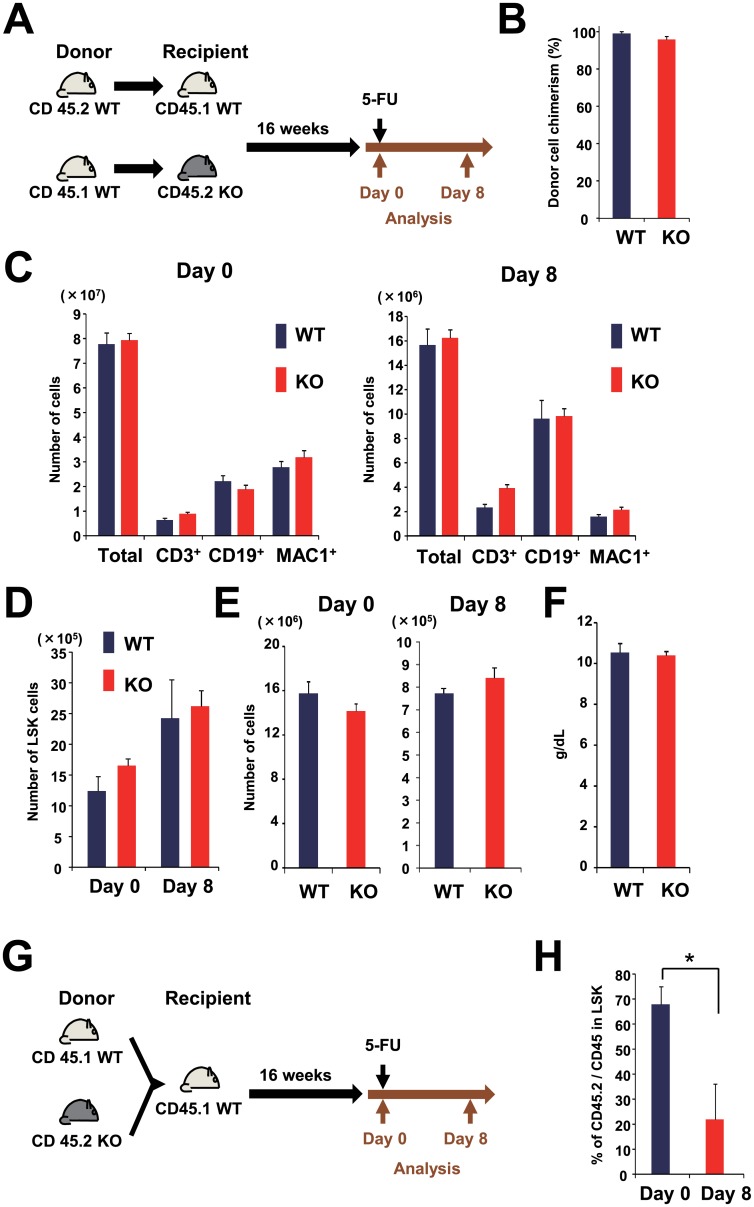
ESAM expression in hematopoietic cells is required for hematopoietic recovery after BM injury.(A-F) 1 × 106 BM cells from CD45.1 WT or CD45.2 WT mice were transplanted to lethally irradiated CD45.2 ESAM-KO or CD45.1 WT mice, respectively (n = 8 in each group). Sixteen weeks after transplantation, half of each group was sacrificed at 5-FU day 0, and others were treated with 150 mg/kg of 5-FU and sacrificed at day 8. (A) A scheme of the transplantation protocol is shown. (B) PB chimerisms that were analyzed by FACS are shown. The blue bar represents the percentages of CD45.1- CD45.2+ cell population among CD45+ cells in WT recipient mice, and the red bar represents the percentages of CD45.1+ CD45.2- cell population in ESAM-KO recipient mice at stable state (5-FU day 0). (C-E) The number of BM cells from a pair of femora and tibiae was analyzed after 5-FU treatment (day 0 and day 8). The number of total BM MNC, CD3+ T cells, CD19+ B cells, MAC1+ myeloid cells (C), LSK cells (D), and c-Kit- Ter119+ CD71Hi erythroid progenitors (E) is shown. (F) PB Hb levels in 5-FU-treated WT and ESAM-KO mice recipients at day 8 are shown. (G, H) Equal amounts (2 × 105) of BM cells from CD45.1 WT and CD45.2 ESAM-KO mice were mixed and transplanted to lethally irradiated CD45.1 WT mice (n = 6). Sixteen weeks after transplantation, half of them were sacrificed at 5-FU day 0, and others were treated with 150 mg/kg of 5-FU and sacrificed at day 8. (G) A scheme of the transplantation protocol is shown. (H) The percentages of CD45.1- CD45.2+ cell population among the LSK fraction in the BM at 5-FU day 0 and day 8 are shown. Data are shown as mean ± SEM. Statistically significant differences are represented by an asterisk (*P < 0.05).